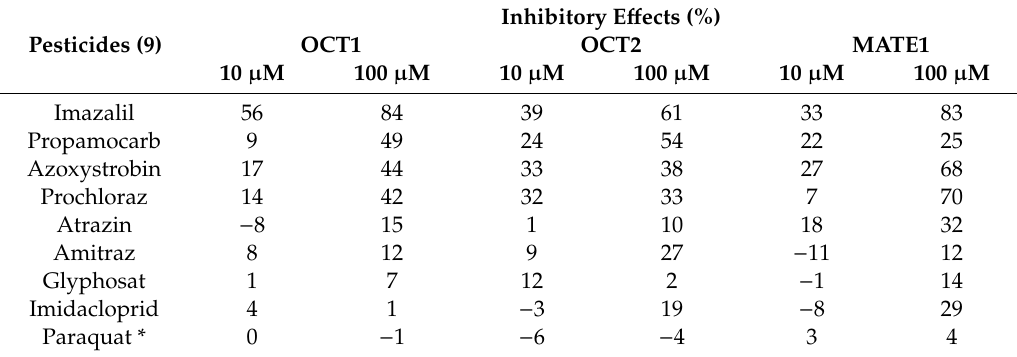
Table 4. Inhibitory e ff ects of various pesticides to hOCT1- and hOCT2-mediated 3 H-MPP uptake and MATE1-mediated 14 C-metformin